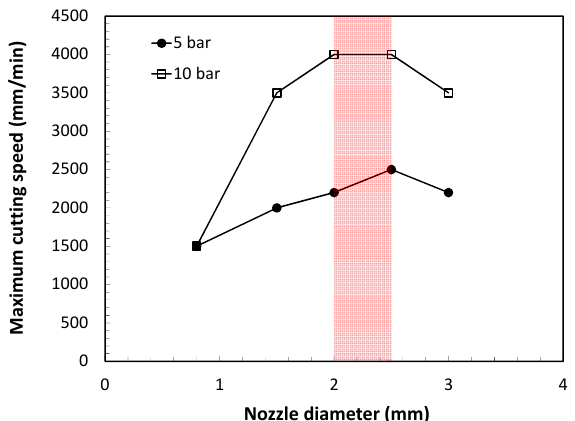
Figure 6. Dependence of the maximum cutting speed on the nozzle exit diameter for two supplying pressures ( p = 5 and 10 bar) during laser cutting of aluminum-cooper alloys 3 mm in thickness (Processing parameters: Laser power P = 2500, stand-off Z = 1.5 mm, focal length f = 127 mm, conical nozzle, assist gas: argon). Adapted with permission from [30]; Copyright 2010 Elsevier.